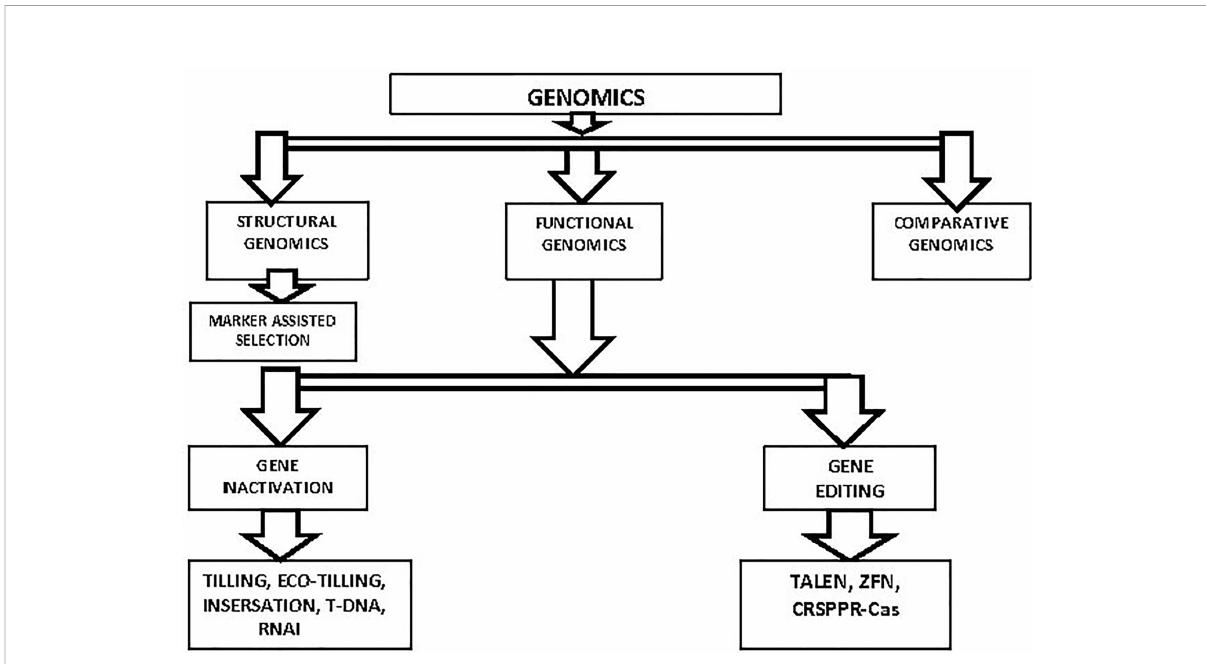
FIGURE 3 Genomic methods for Rice improvement are. Three main groups of genomic techniques are distinguished: (1) structural genomics, which involves general gene structure and aids in the creation of physical maps; (2) functional genomics, which uses approaches such as gene inactivation and gene editing to identify a gene ’ s speci fi c function; and (3) comparative genomics, which uses the reference genome sequence of a species to identify gene families in the species of